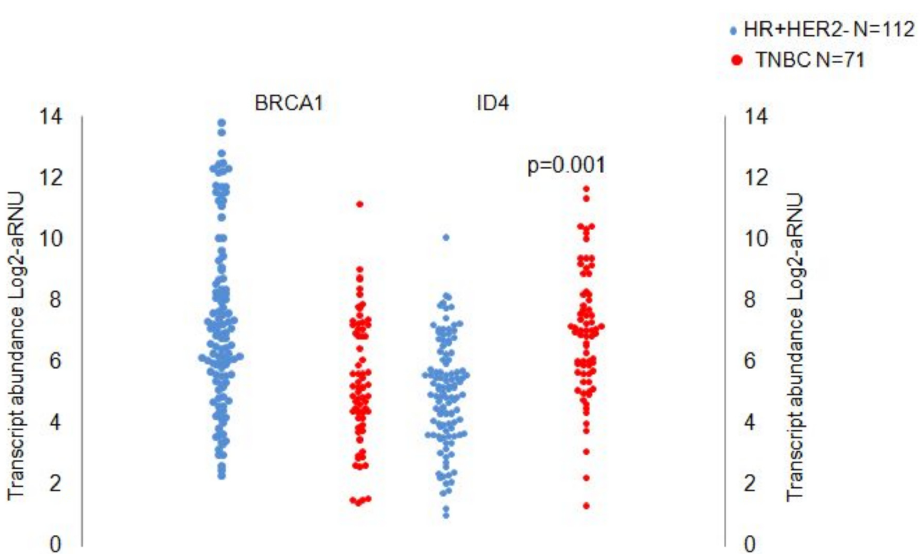
Fig 2. Transnscript abundance of BRCA1 and ID4 in TNBC Vs HR+HER2-ve tumors. Transcript abundance of BRCA1 and ID4 in HR+HER2-veand TNBCs. Median expression of BRCA1 and ID4 transcripts is significantly different in the two groups; * p = 0.008 for BRCA1, and ** p = 0.001 for ID4, (Mann Whitney U Test). The high ranges of BRCA1 are exclusively HR+, and the high-ranges of ID4 are all TNBCs.